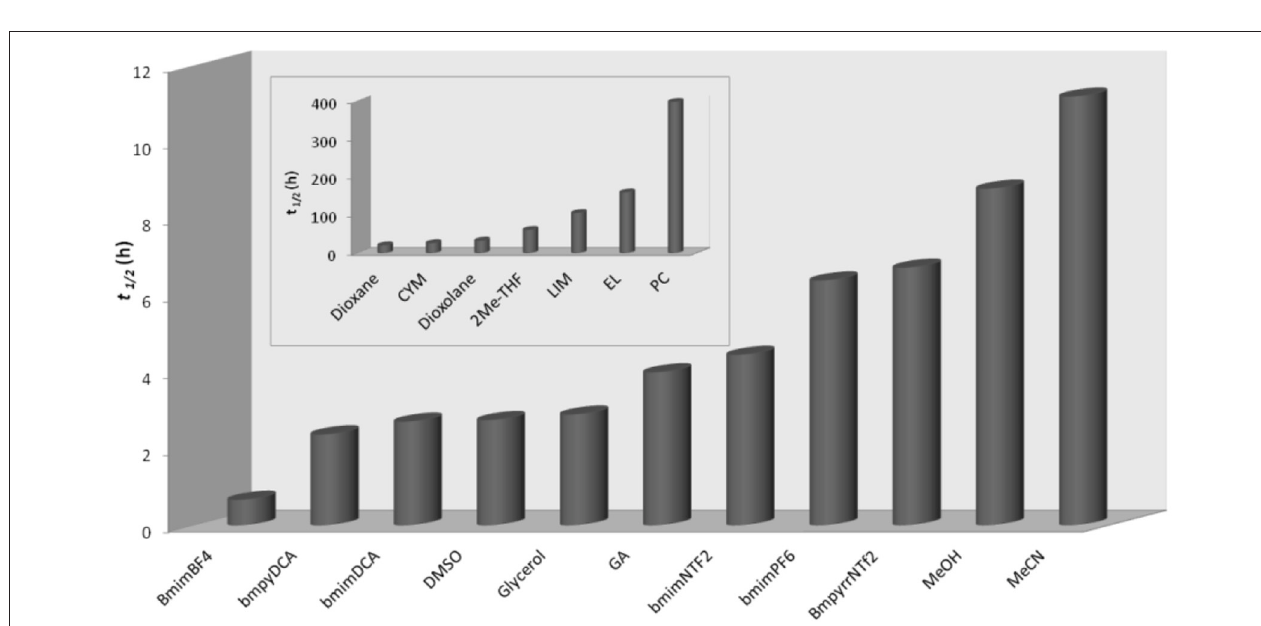
FIGURE 2 | Half-life (t 1 / 2 ,h) for degradation of 1 with piperidine (0.7M) in several solvents. Each measurement was made in triplicate.